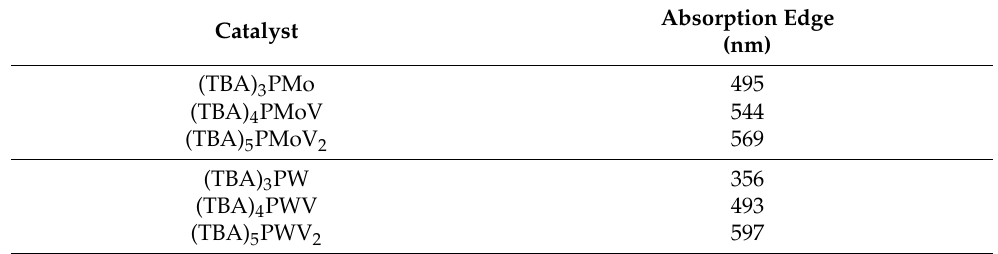
Table 1. Absorption edge energy of the pure and substituted Mo and W